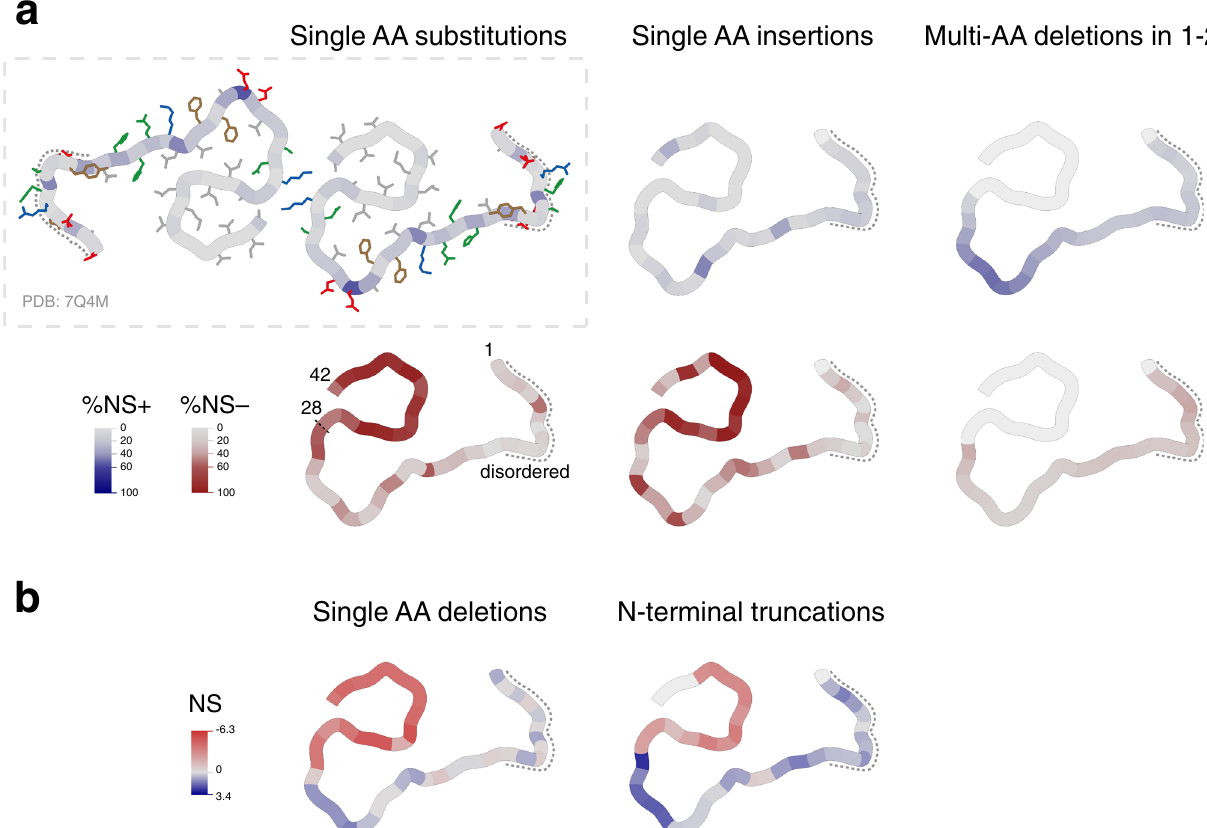
Fig. 5 | Mutational effects visualized on fAD A β fi bril structure. In fi brils extractedfromthebrainsoffADpatients,A β 42adoptsanS-shapedstructureatthe C-terminus with an N-terminal arm linking to an unstructured region (AA 1 – 11) indicated by the dashed line (PDB: 7Q4M 5 . a Single AA substitutions, single AA insertions, and multi-AA deletions in AA 1 – 28: color intensity indicates the per- centage of NS+ (blue) or NS − (red) mutations at each position or losing each